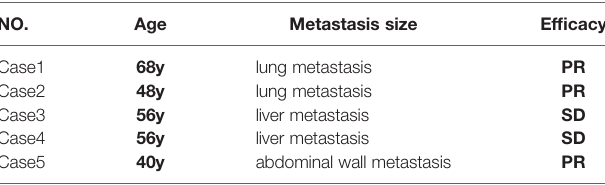
TABLE 1 | The summary of outcomes for all treated patients.